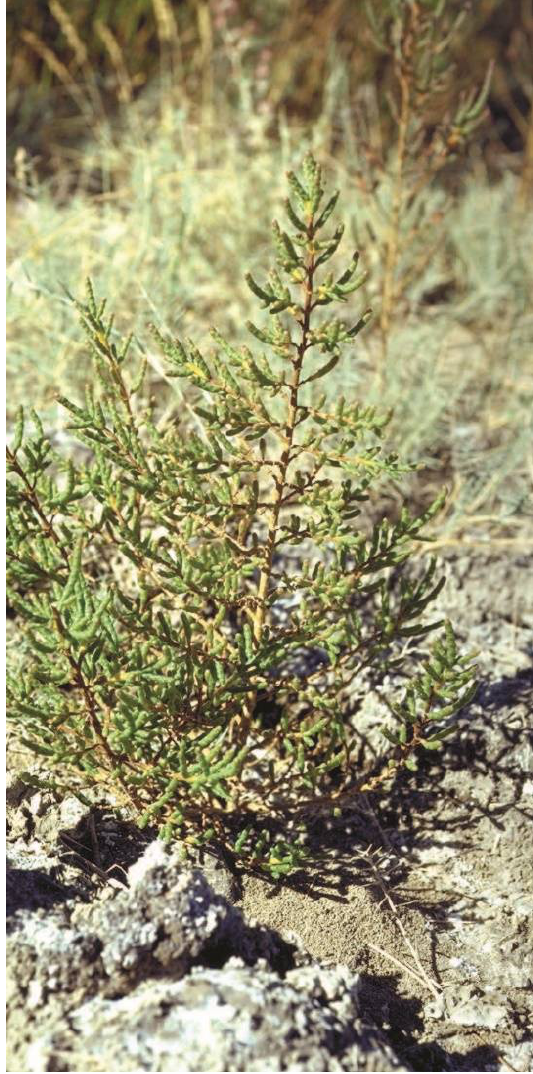
Figure 3. Photograph of Salicornia herbacea in its natural habitat (Finistère, France).